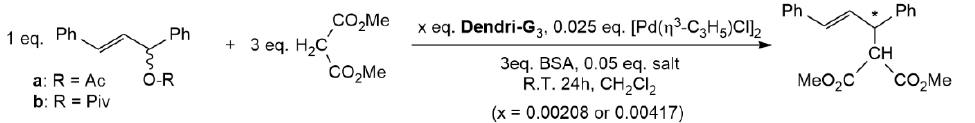
Figure 3. Allylic alkylation catalyzed by the Pd complex of the G 3 dendrimer shown in Scheme 3. Another example of bifunctional monophosphine concerns a thiazolyldiphe- nylphosphine grafted on the surface of generations 1 and 3 of PPH dendrimers (Scheme